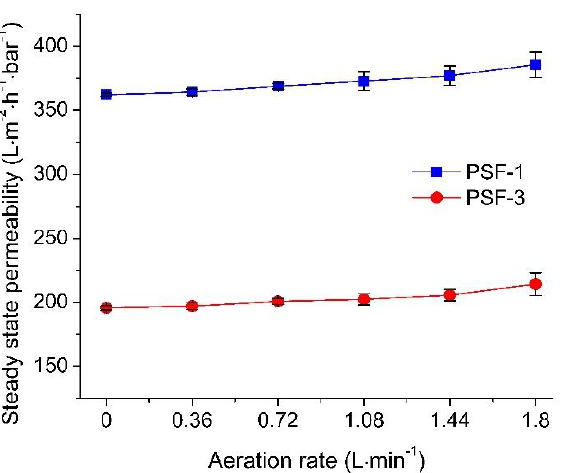
Figure 5. The e ff ects of aeration rate on the steady state permeability of PSF membranes with Figure 5. The effects of aeration rate on the steady state permeability of PSF membranes with different di ff erent composition.